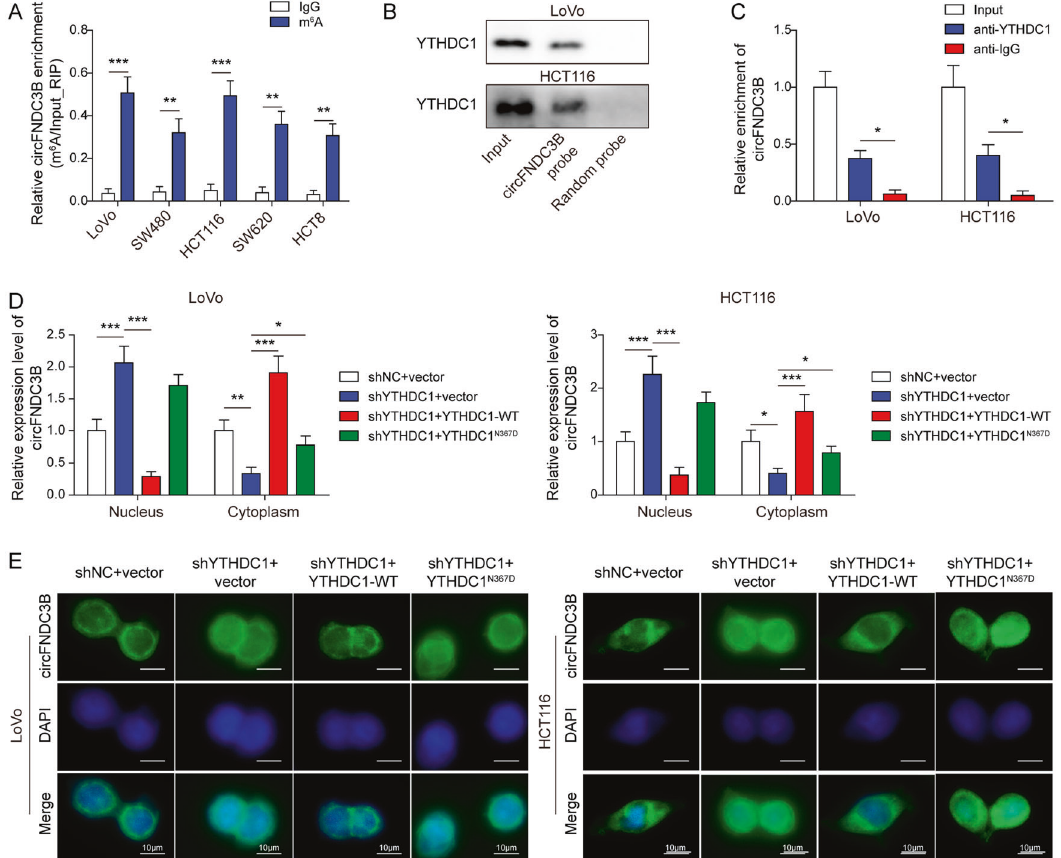
Fig. 3 YTHDC1 promotes cytoplasmic translocation of m 6 A modi fi ed circFNDC3B. A m 6 A modi fi cation of circFNDC3B was detected by MeRIP-qPCR. B The interaction between biotinylated circFNDC3B and YTHDC1 was veri fi ed by RNA pull-down assay. Random probe acted as a negative control. C The interaction between circFNDC3B and YTHDC1 was detected by RIP assay. Normal IgG served as a negative control. D The circFNDC3B level in CRC cells was detected by subcellular fractionation and qRT-PCR. E The subcellular localization of circFNDC3B was detected by RNA FISH. Scale bar, 10 μ m; Green, circFNDC3B; Blue, DAPI. ** P < 0.01, *** P <